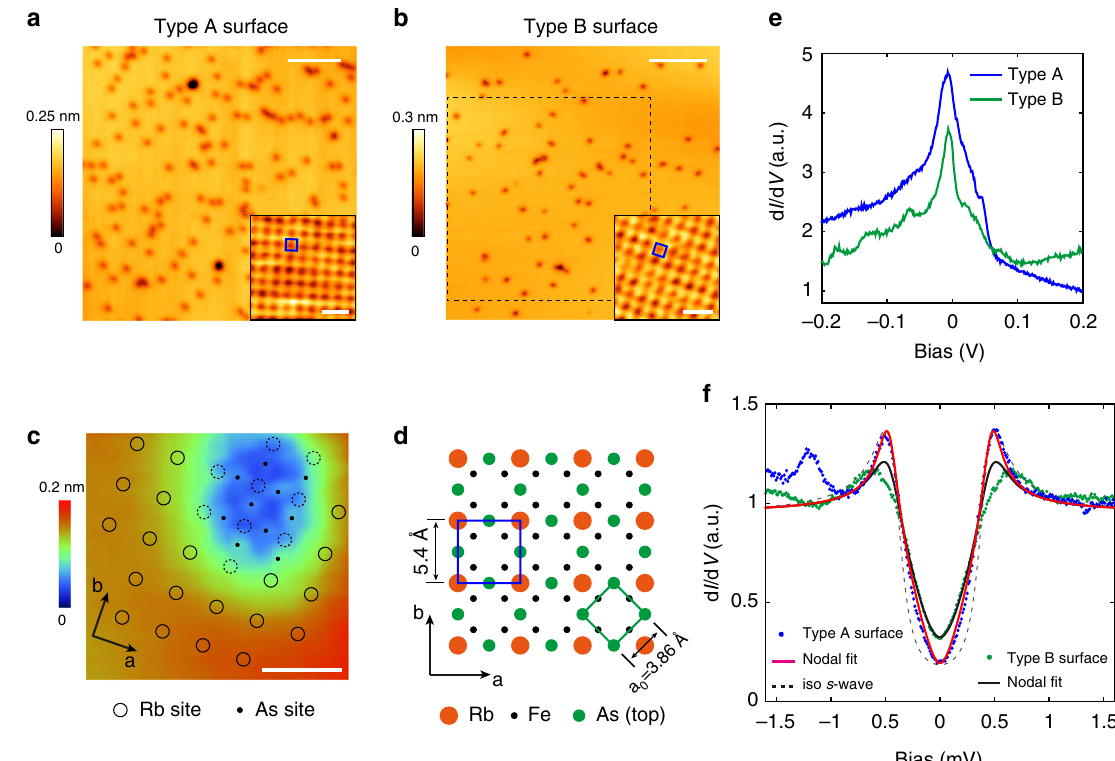
Fig. 1 Surface atomic structure and tunneling spectrum of cleaved RbFe 2 As 2 . a Topographic image of type A surface (55 × 55 nm 2 , V b = 150 mV, I = 100 pA, scale bar: 10 nm), inset is atomically resolved image of a defect-free area (scale bar: 1 nm), showing a square lattice with a lattice constant of 5.4 Å. b Topographic image of type B surface (75 × 75 nm 2 , V b = 1 V, I = 10 pA, scale bar: 10 nm). Inset is atomically resolved image of a defect-free area (scale bar: 1 nm), showing a similar lattice to type A surface. QPI mapping on type B surface was performed in the dashed square. c A closer image of a large basin defect ( V b = 6 mV, I = 3 nA, scale bar: 1 nm) reveals a different atomic lattice inside the basin. We attribute these atoms to the As layer beneath the surface Rb layer. d Sketch of surface atomic structure. The surface is half covered by Rb and forms a layer. e d I /d V spectra on both surfaces (setpoint: type A surface: V b = 200 mV, I = 100 pA, Δ V = 1 mV; type B surface: V b = 200 mV, I = 50 pA, Δ V =